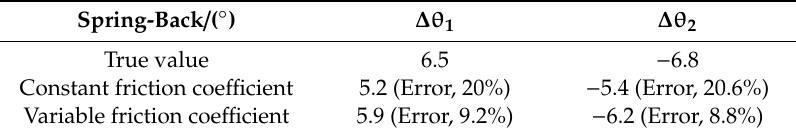
Table 6. Comparison of simulation and test results of the rebound